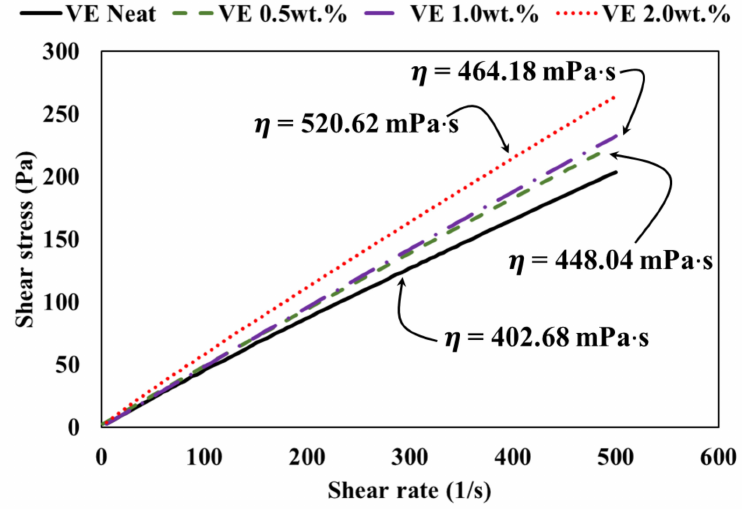
Figure 4. Vinyl ester resin shear stress versus shear rate with varying MWCNTs